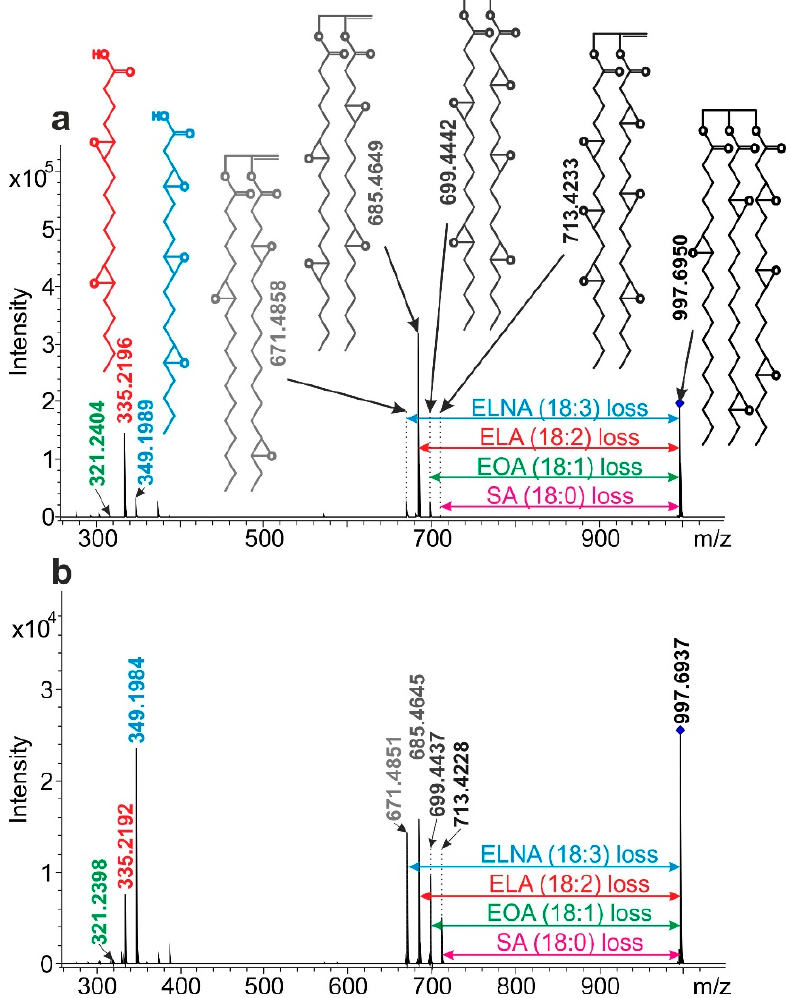
Figure 3. MS/MS spectra of the sodiated (57:6) ETG adduct at m / z 997 of the ( a ) linseed and ( b ) soybean oil recorded at a laboratory frame collision energy of 70 eV. Abbreviations: SA, stearic acid (18:0); EOA, epoxidized oleic acid, (18:1); ELA, epoxidized linoleic acid (18:2); ELNA, epoxidized linolenic acid (18:3). The chemical structure of the precursor ion ( m / z 997) is just an example, it can also contain, for example, three ELA (18:2) chains.